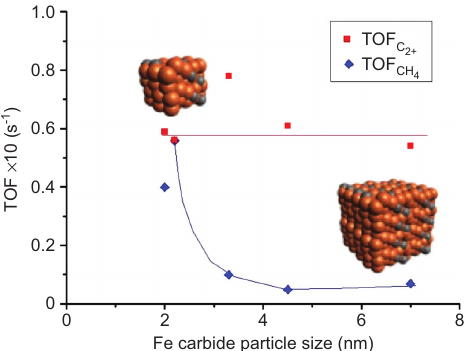
Figure 3 Relative concentration of dissociated CO species on 4, 10, and 15 nm NPs after exposure to CO/He at different